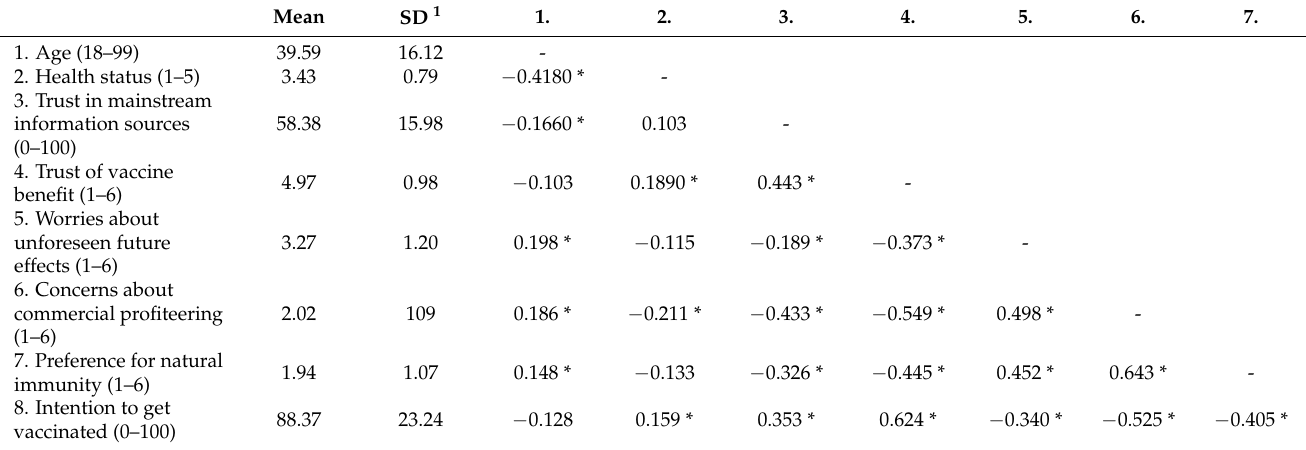
Table 2. Means, standard deviations, and the correlations between the key variables under